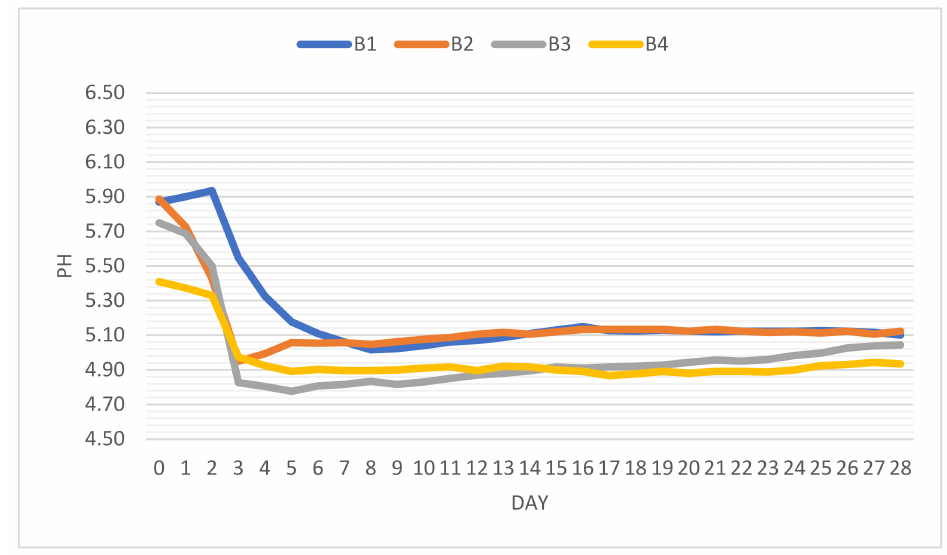
Figure 3. Representation of pH variation during the fermentation and drying process of four batches of salami, obtained with different sources of